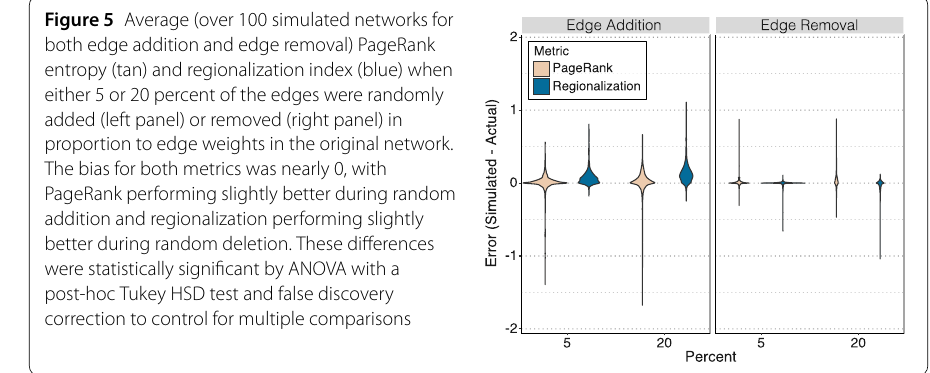
Figure 5 Average (over 100 simulated networks for both edge addition and edge removal) PageRank entropy (tan) and regionalization index (blue) when either 5 or 20 percent of the edges were randomly added (left panel) or removed (right panel) in proportion to edge weights in the original network. The bias for both metrics was nearly 0, with PageRank performing slightly better during random addition and regionalization performing slightly better during random deletion. These